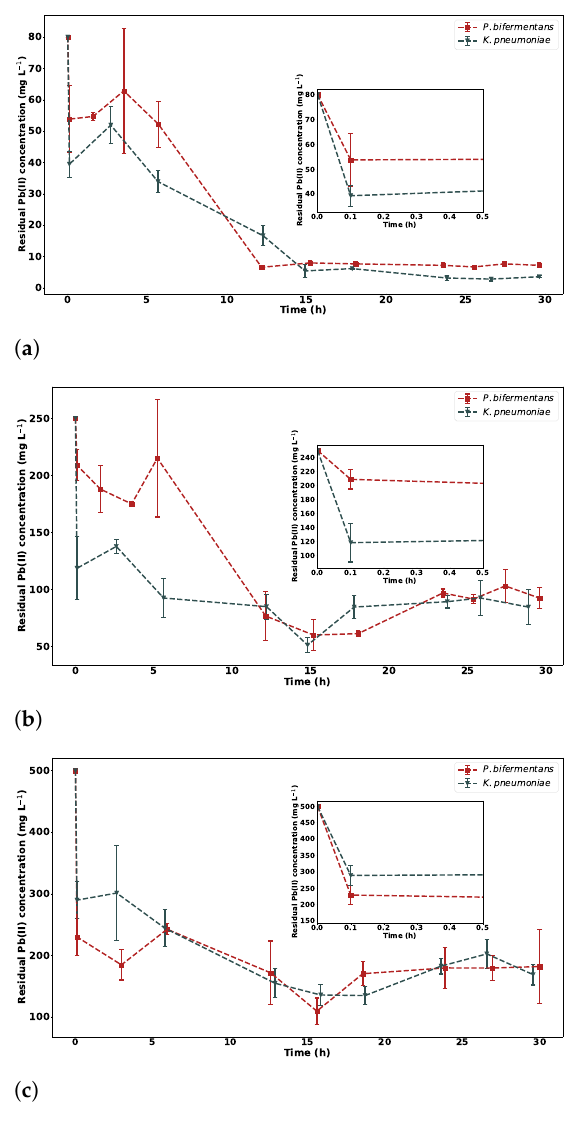
Figure 7. The residual Pb(II) concentration for P. bifermentans and K. pneumoniae at ( a ) 80 mg L − 1 , ( b ) 250 mg L − 1 and ( c ) 500 mg L − 1 initial Pb(II) concentration with n = 3, with an inset graph depicting the initial 30 min of the